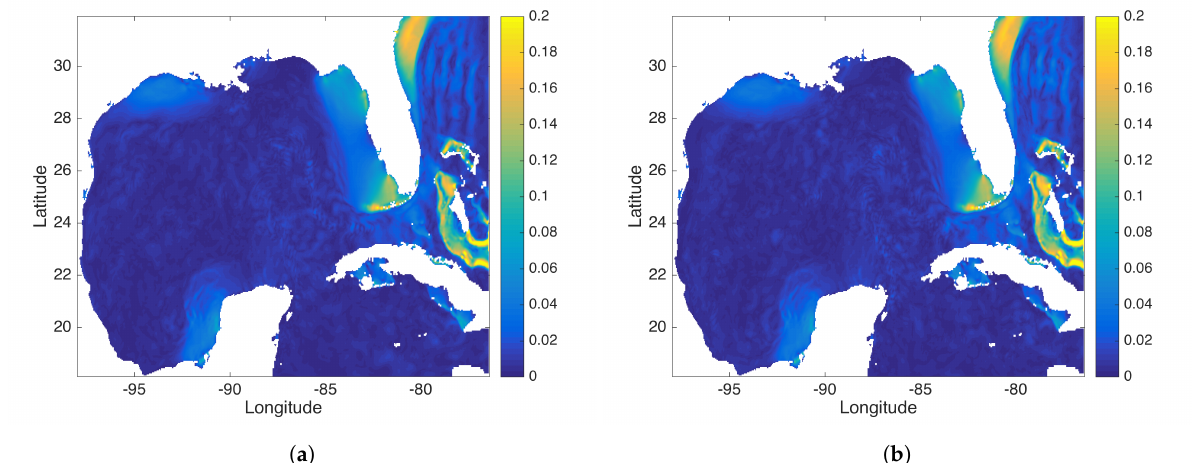
Figure 13. This figure compares the ( a ) DMD and ( b ) rDMD mode associated with the M2 tidal frequency. This mode capture the “red